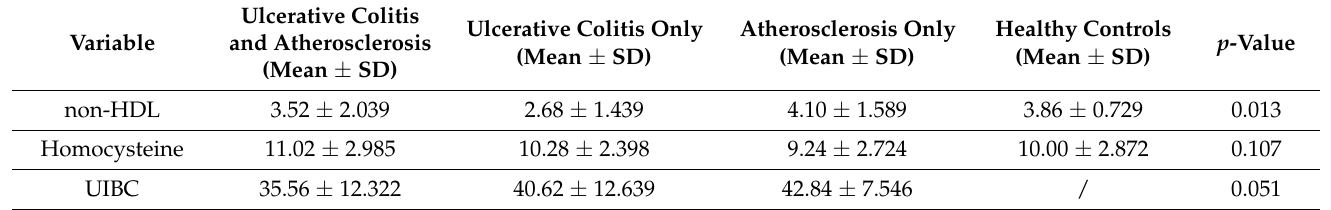
Table 2. The difference in non-HDL, homocysteine, and UIBC between the four study groups.